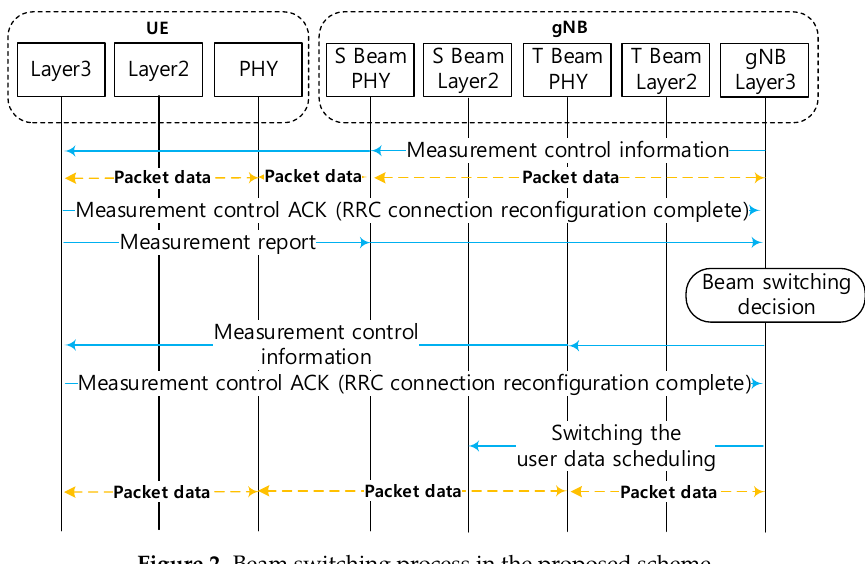
Figure 2. Beam switching process in the proposed